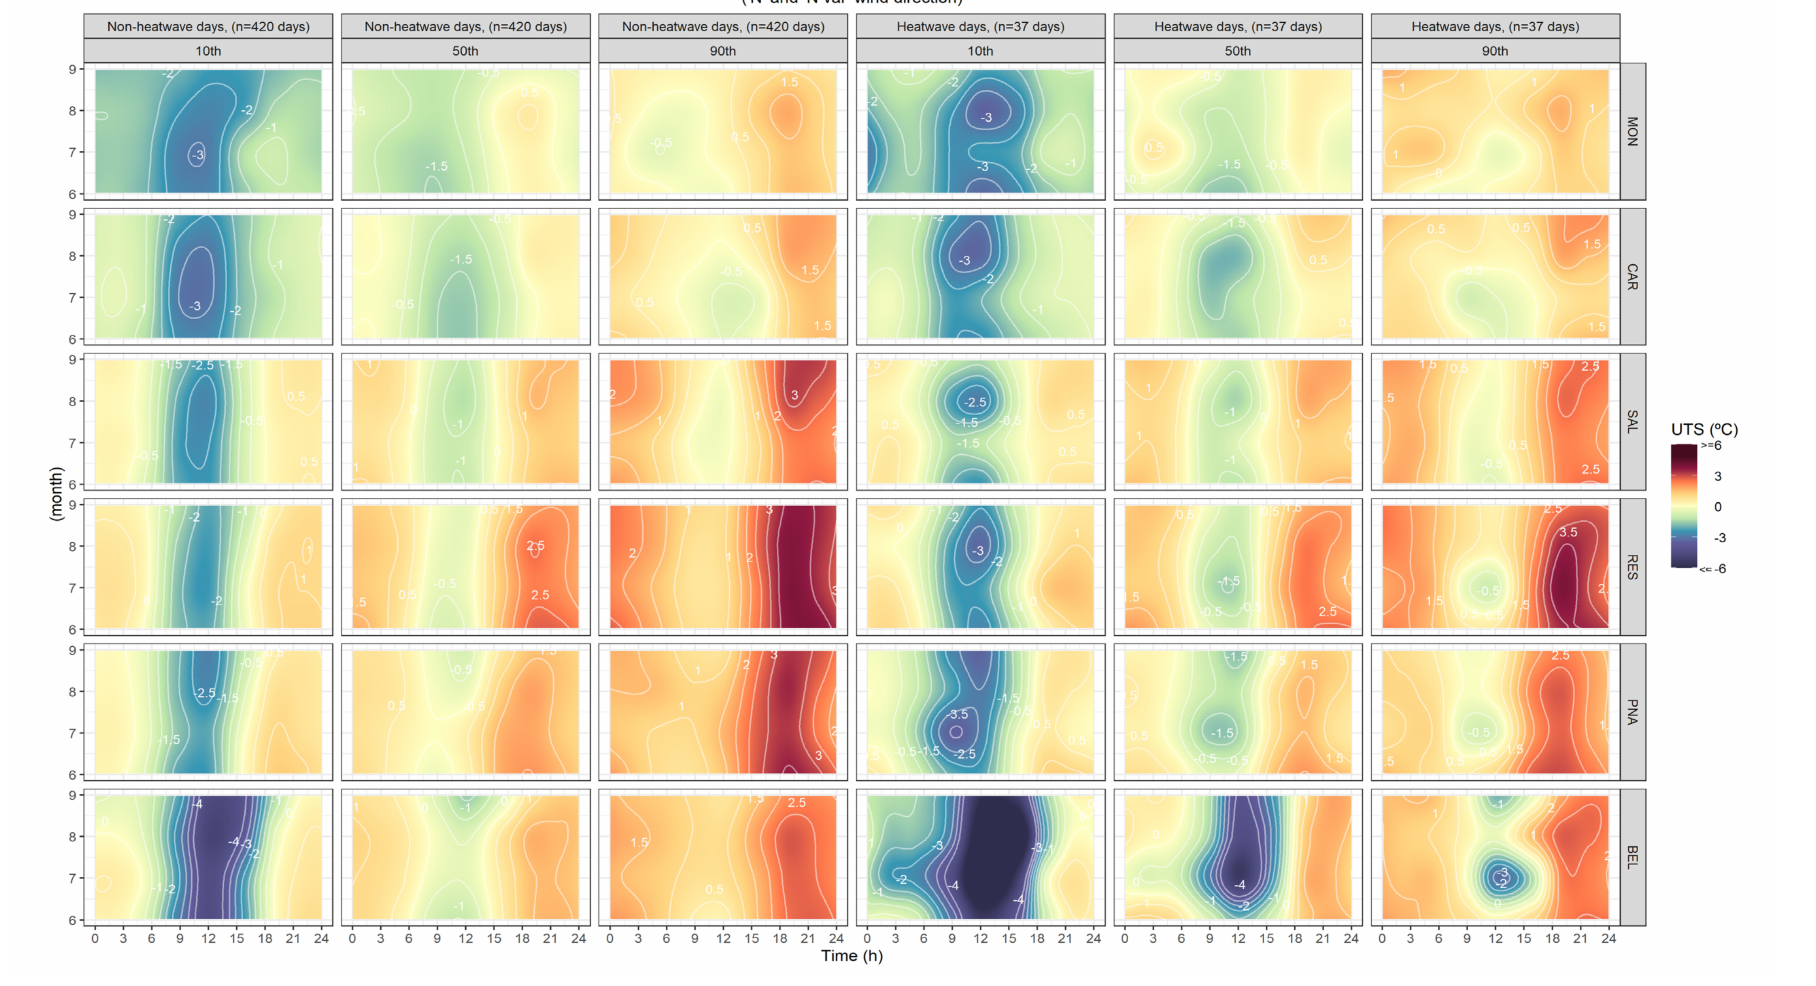
Figure 7. Hourly UTS intensities in days with north-prevailing wind direction, per hour and month: the three lefthand-side columns respectively represent the 10th, 50th, and 90th UTS percentiles in non-heatwave days, and the three right-hand-side columns represent the 10th, 50th, and 90th UTS percentiles in heatwave